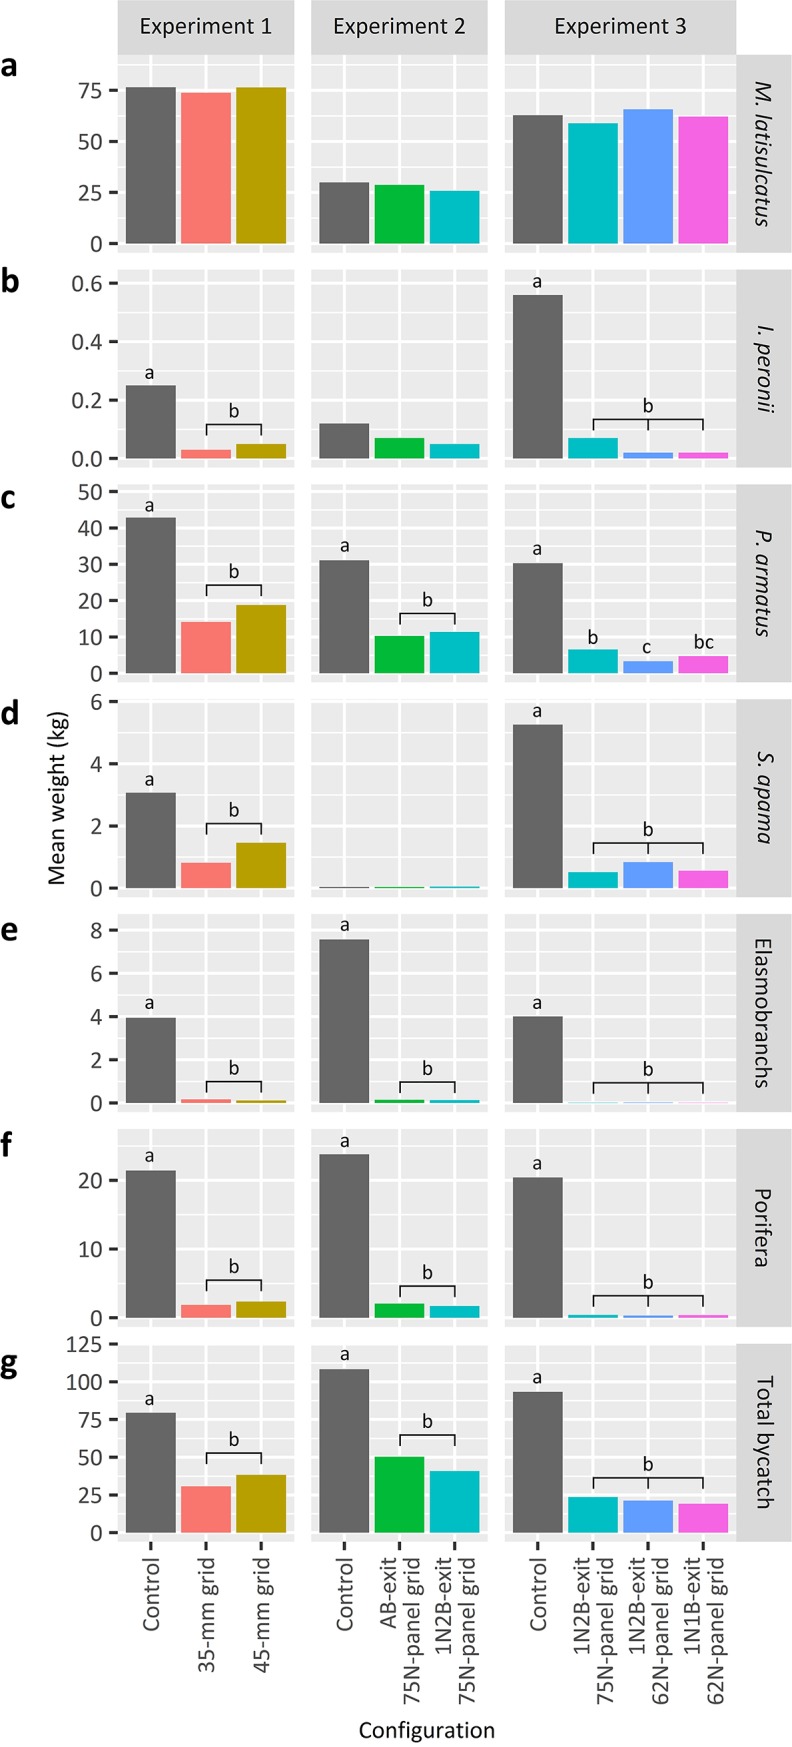
Predicted mean catch weights 30 min-1
of (a) Melicertus latisulcatus, (b) Ibacus peronii, (c) Portunus armatus, (d) Sepia apama, (e) elasmobranchs, (f) porifera and (g) total bycatch by configuration and experiment. Where there was a significant effect (p < 0.05) among a species/group within an experiment, letters above bars denote the false-discovery-rate (FDR) adjusted pairwise comparisons of the configurations (p < 0.05).